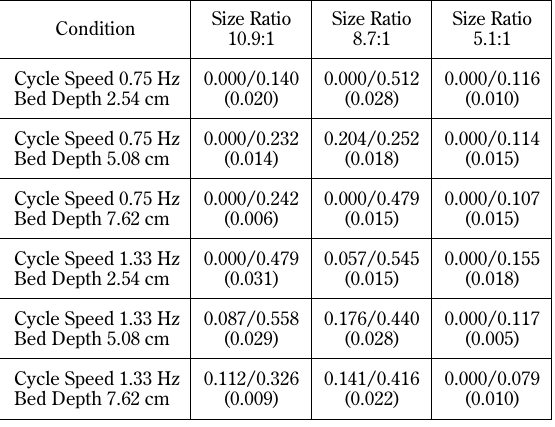
Table 6 Convective-diffusive segregation constitutive model para- meter values ( µ / δ ) at 5% strain with standard deviations between data and model in parentheses *